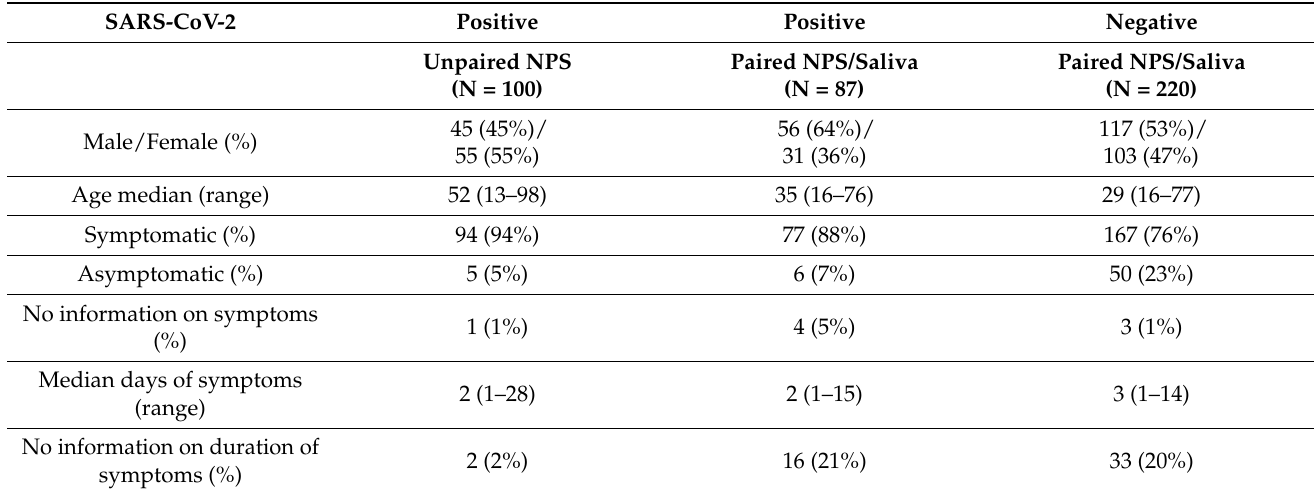
Table 1. Donor demographics.